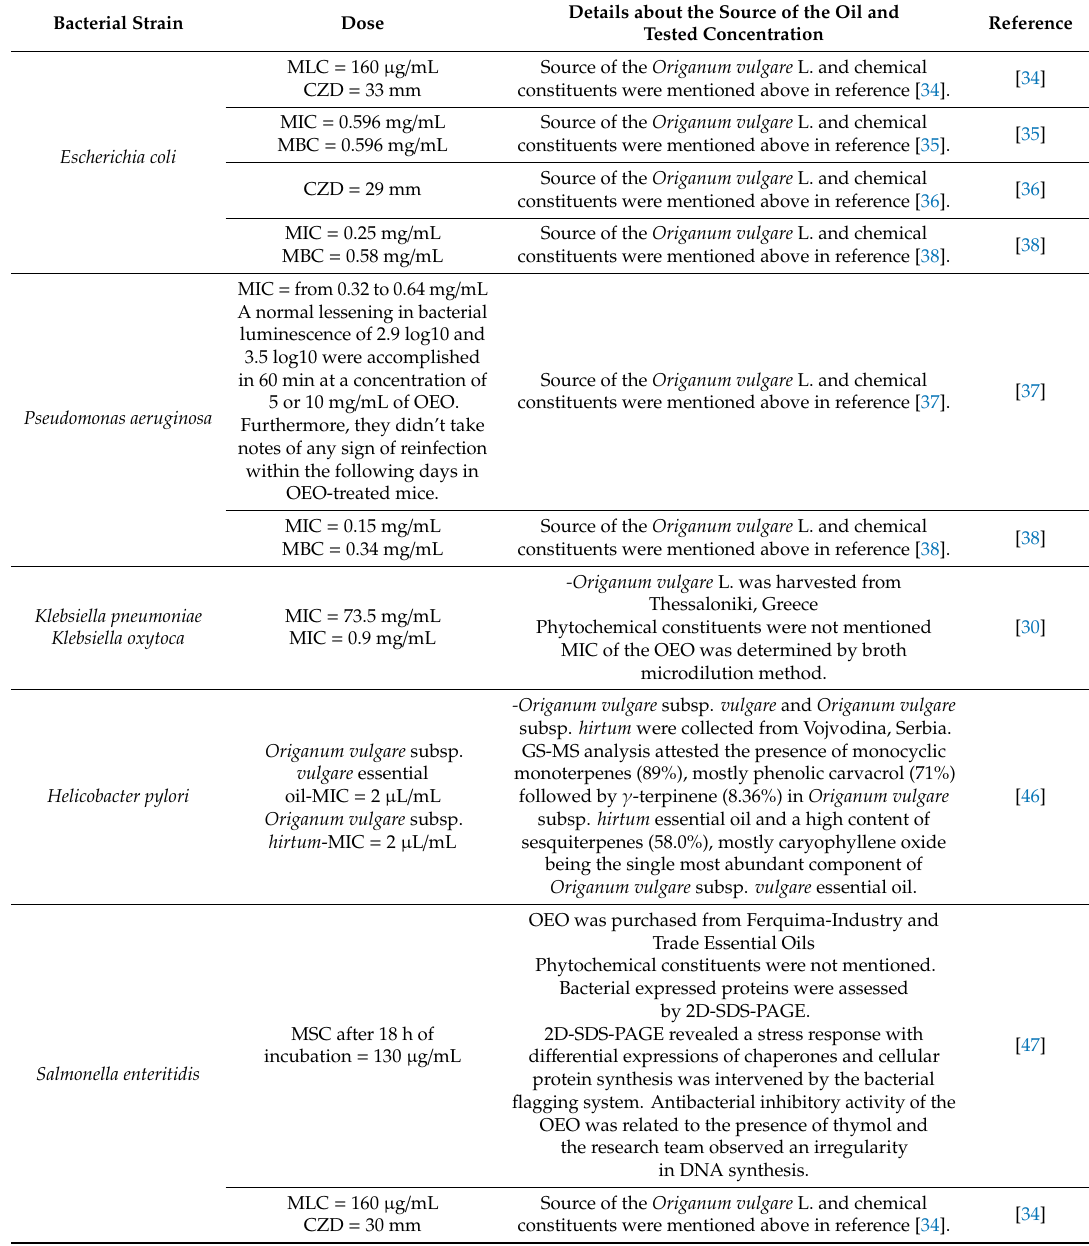
Table 2. Antibacterial activity against Gram-negative